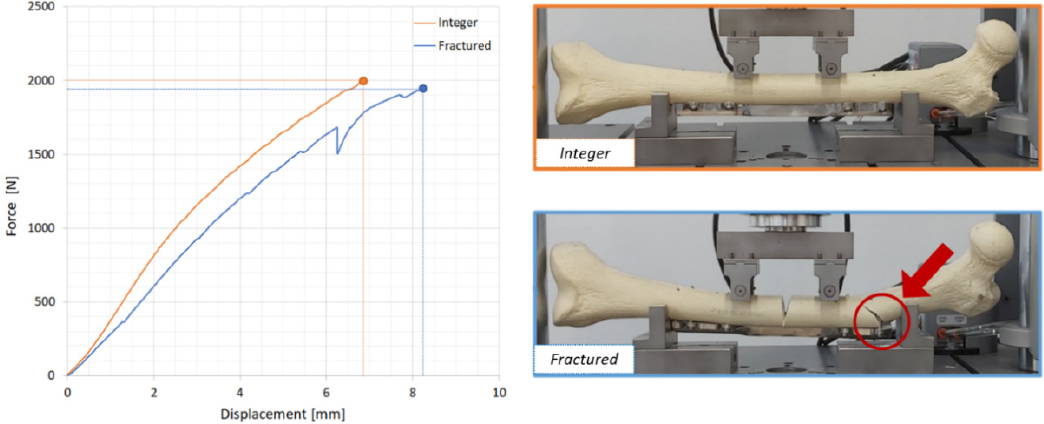
Figure 12. Force-displacement curves obtained from the experimental tests for integer and fractured samples: the red arrows mark the point where the femur broke.